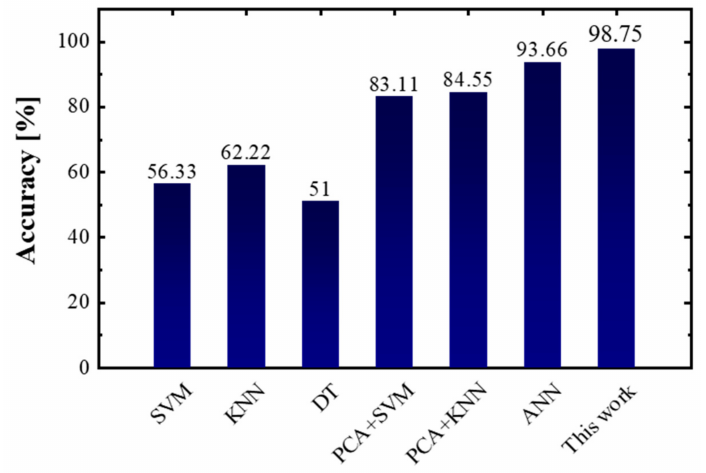
Figure 10. The overall accuracy of all the gas recognition methods for